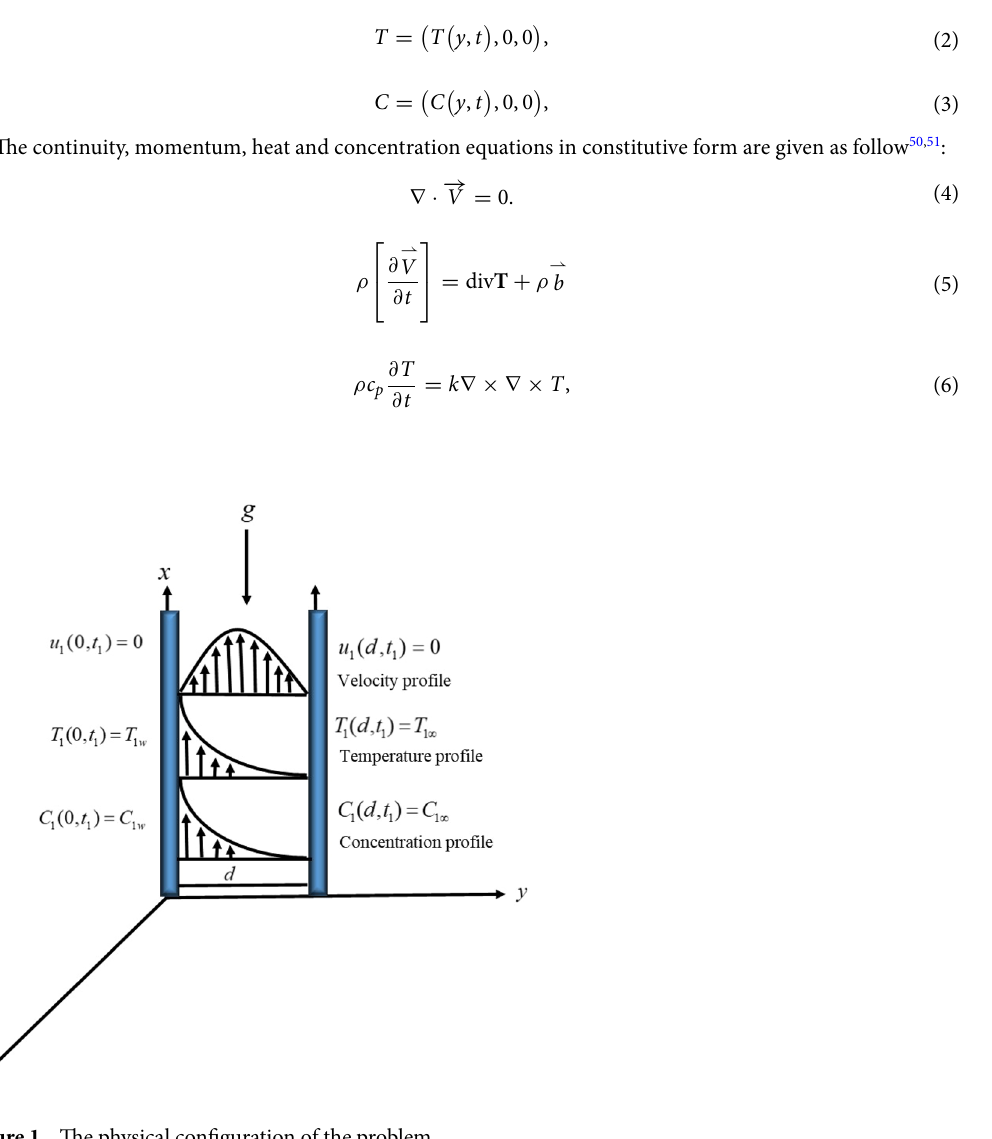
Figure 1. The physical configuration of the